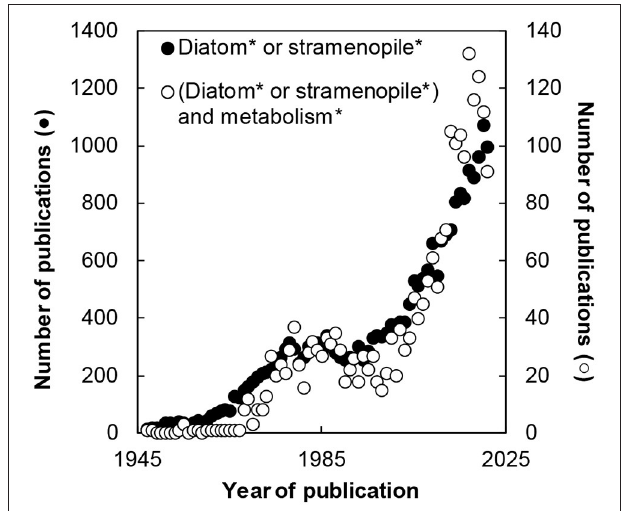
FIGURE 1 | Progression of the number of publications on diatom’s